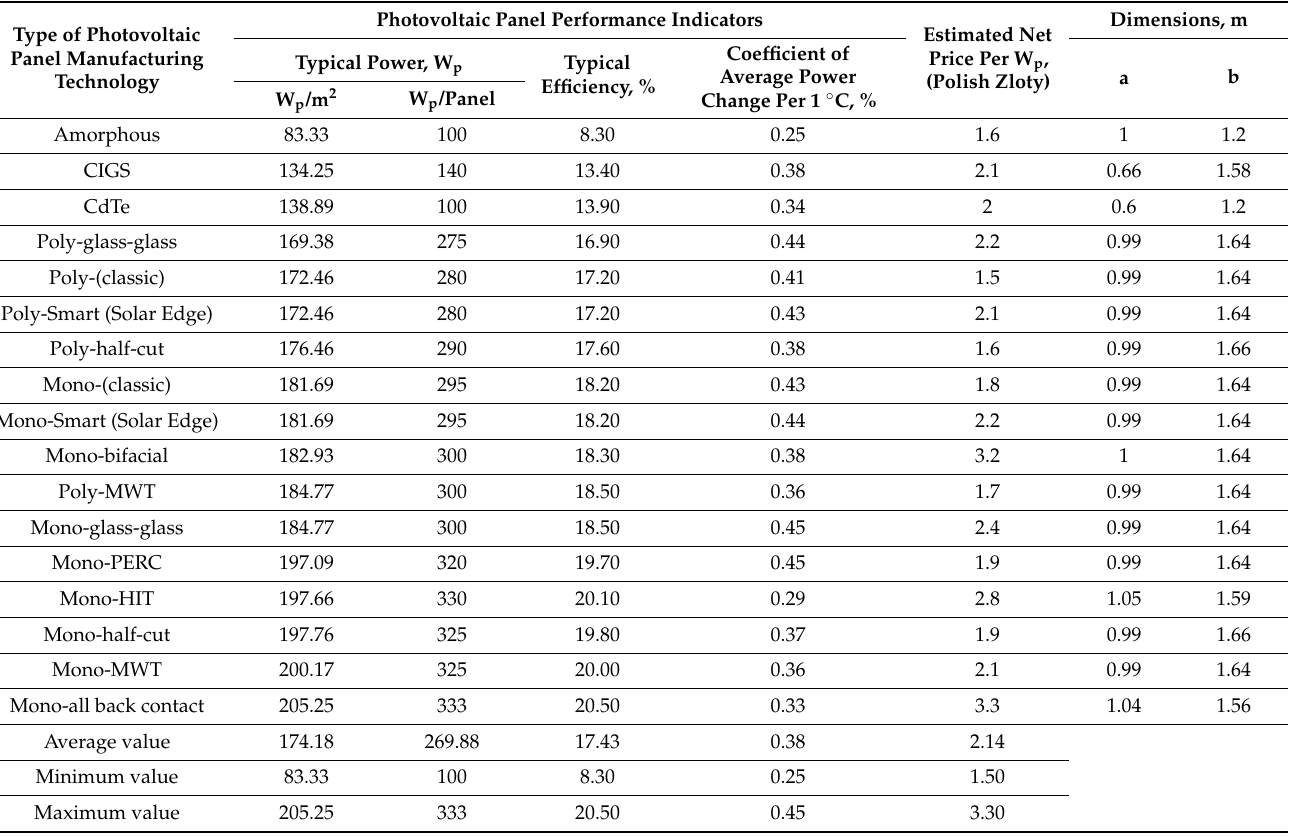
Table 1. Preliminary technical data and background information on the types of photovoltaic panels selected for analysis, made with 17 different